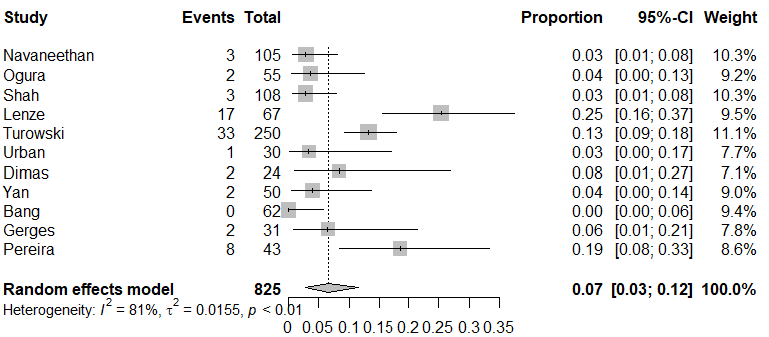
Figure 4. The forest plot of studies that reported a pooled adverse event rate of 7%.